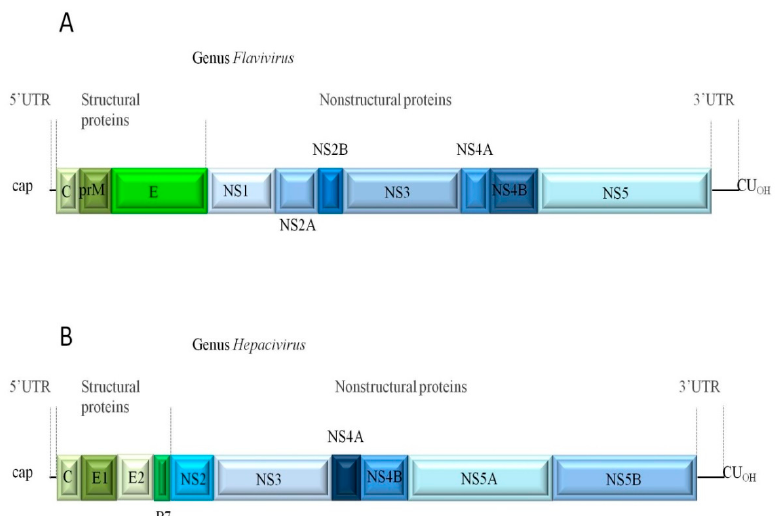
Figure 1. Schematic view of the genomic organization of flaviviruses ( A ) and hepaciviruses ( B ). UTR: untranslated region; C: capsid or core protein; prM: pre-membrane protein; p7: polypeptide 7; E: envelope protein; NS: non-structural proteins.